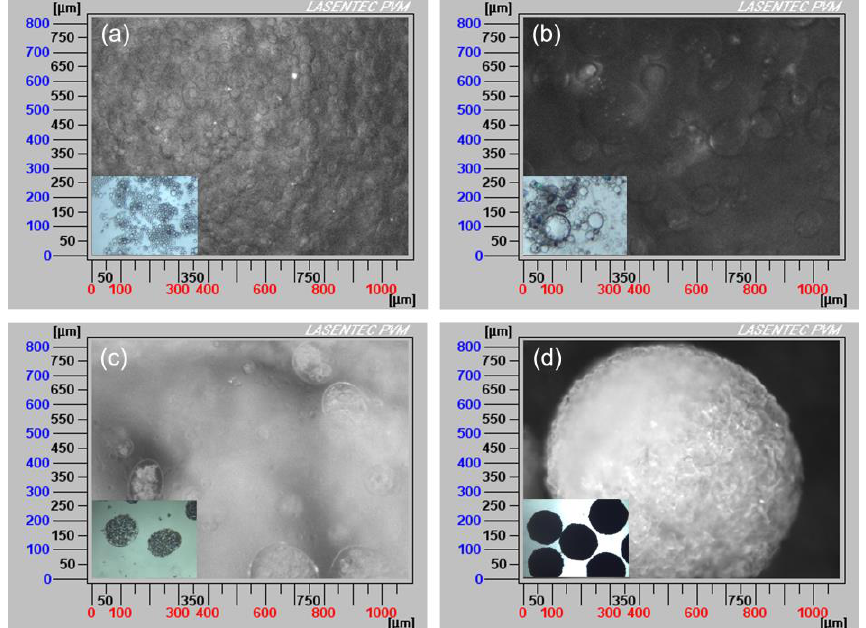
Figure 5. Particle visual microscope (PVM) images of the spherical agglomeration process with the addition of different volumes of water: ( a ) 15 mL, ( b ) 25 mL, ( c ) 45 mL, ( d ) 90 mL (insets: optical microscope images).